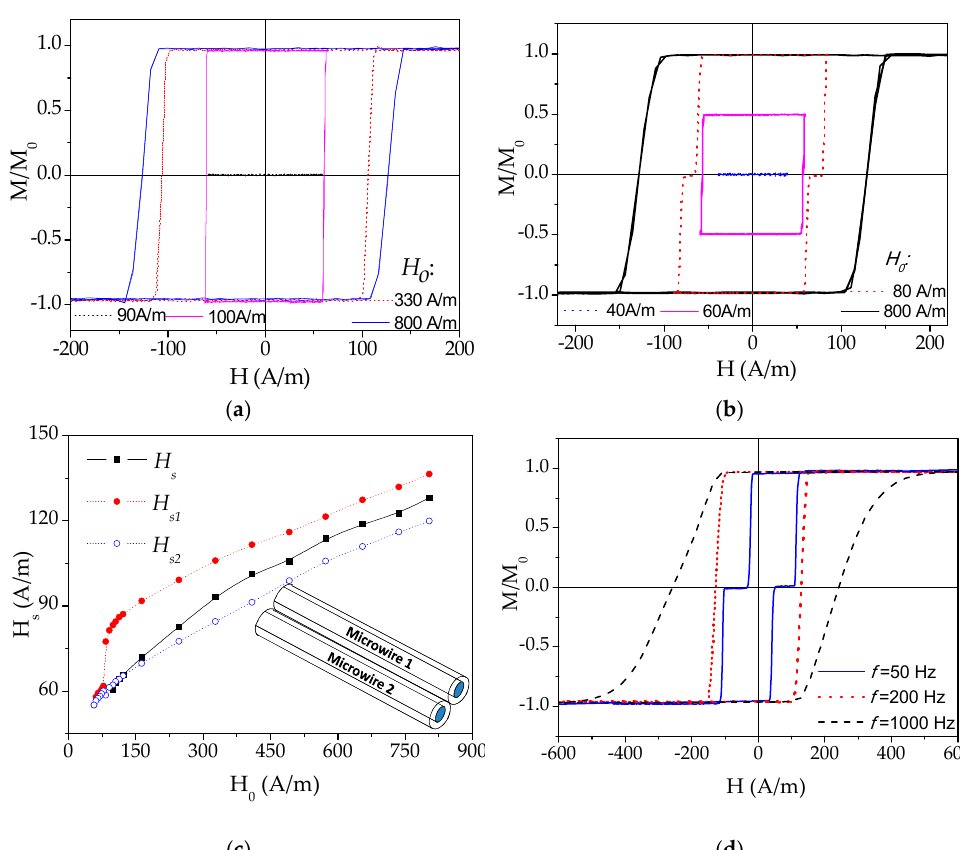
Figure 5. Hysteresis loops measured at different magnetic field amplitudes, H 0, for a single glass-coated Fe 74 B 13 Si 11 C 2 microwire ( d = 19.4 μ m) ( a ), and array with two microwires ( b ); dependence of switching field, H s , on H 0 for a single microwire (solid line) and for an array containing 2 microwires, H s 1 and H s 2 (dot-line) ( c ); hysteresis loops of the two microwires measured at different magnetic field frequencies, f ( d ). The schematic picture of the microwires array is provided in the inset of ( c ). Reprinted with permission from [50].